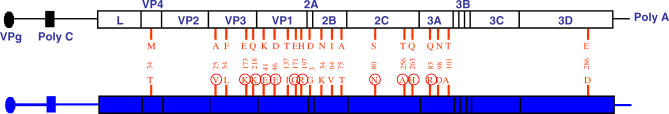
Amino Acid Substitutions Found in the FMDV
Genome as Compared to FMDV C-S8c1
The FMDV C-S8c1 genome (8,115 residues excluding the internal poly(C) and the 3′ poly(A)) composed of the 5′ and 3′ UTRs (lines) and coding regions (boxes), which include protease L, structural proteins (VP4, VP2, VP3, and VP1), and non-structural proteins (2A, 2B, 2C, 3A, 3B, 3C, and 3D). Genomic regions are based in [14] and references therein; VPg is the protein (3B) covalently linked to the 5′ end of the RNA, poly(C) is the internal polyribocytidylate tract, and poly(A) is the 3′ terminal polyadenylate tract. The FMDV C-S8c1- and
-coding regions are represented in white and blue, respectively. Amino acids in
that differ from the corresponding ones in C-S8c1 are indicated in red. Replacements found also in the
genome are encircled. Numbering of amino acids for each individual protein is as in [11].